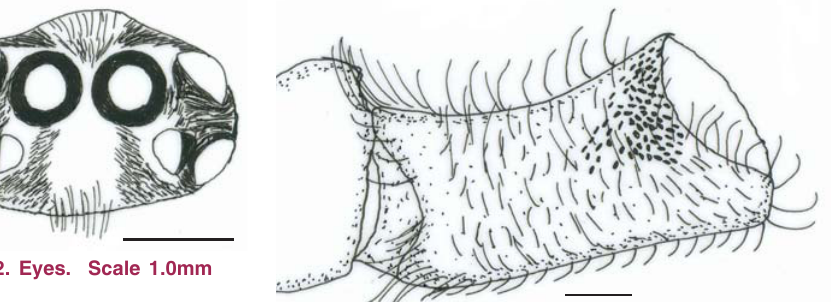
10.0mmFigure Figure 3. Maxilla, ventral view. Scale 1.0mm Figure 6. Chelicerae, prolateral face. Scale Figure 4. Maxillary lyra. Scale 1.0mm 1.0mmFigure Figure 8. Sternum. Scale Figure 7. Chelicerae, retrolateral face. Inset, Chelicerae lyra setae. Scale 1.0mm Figure 10. Spermathecae. Scale